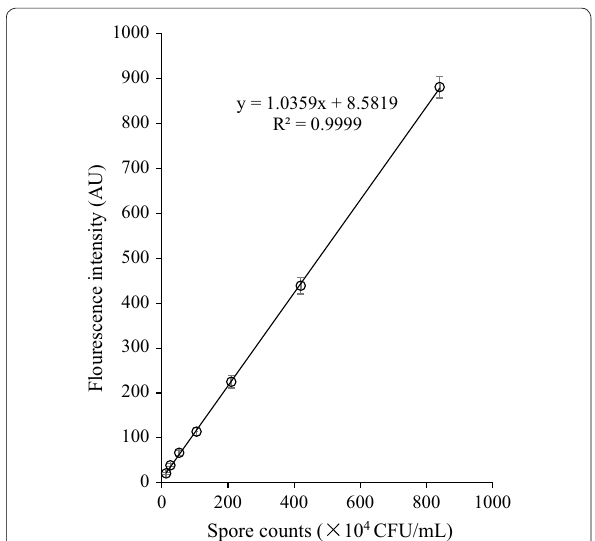
Fig. 1 Calibration curves of spore counts of B. amyloliquefaciens BS‑20 and their fluorescence intensity. The spores of B. amyloliquefa- ciens BS‑20 with 1.34 10 8 CFU/mL were twofold serially diluted and × treated for the detection of fluorescence